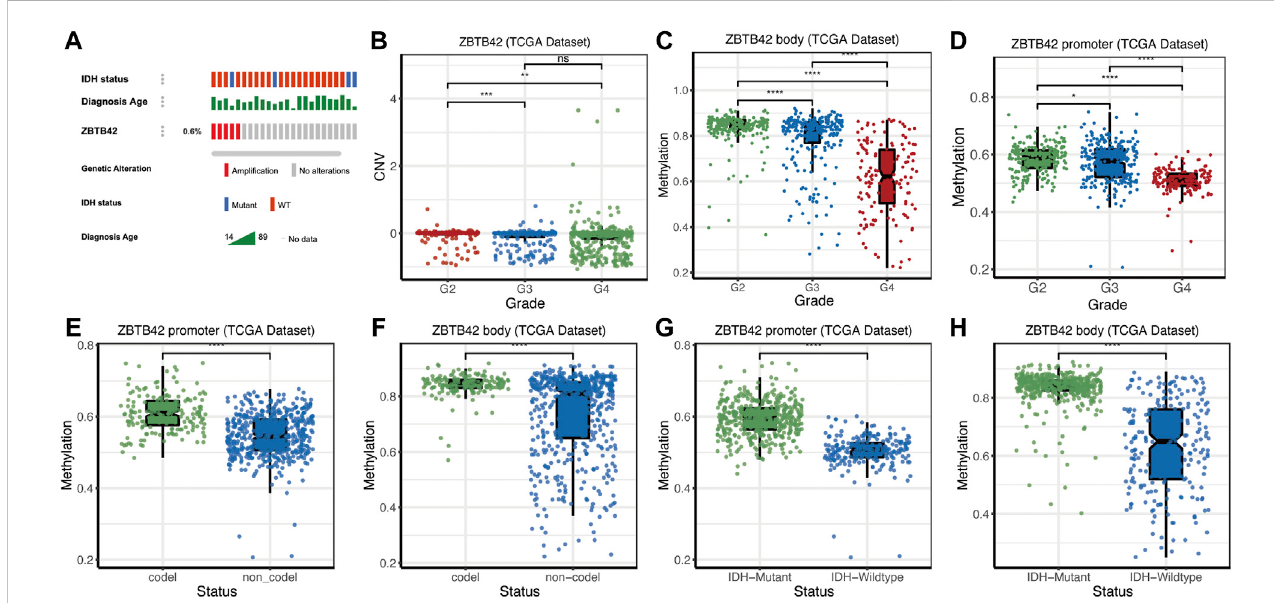
FIGURE 3 The copy number variations, mutation and epigenetic modi fi cation of ZBTB42 (A) Ampli fi cation state of ZBTB42 in glioma. (B) Copy number variations (CNVs) changes ofZBTB42. (C,D) Methylation of ZBTB42 promoter and ZBTB42body indifferentWHO grades glioma. (E,F) Methylation of ZBTB42 promoter and ZBTB42 body in 1p19q codel and 1p19q non-codel subgroups. (G,H) Methylation of ZBTB42 promoter and ZBTB42 body in IDH wild type and mutant subgroups. * p < 0.05; ** p < 0.01; *** p < 0.001; **** p <